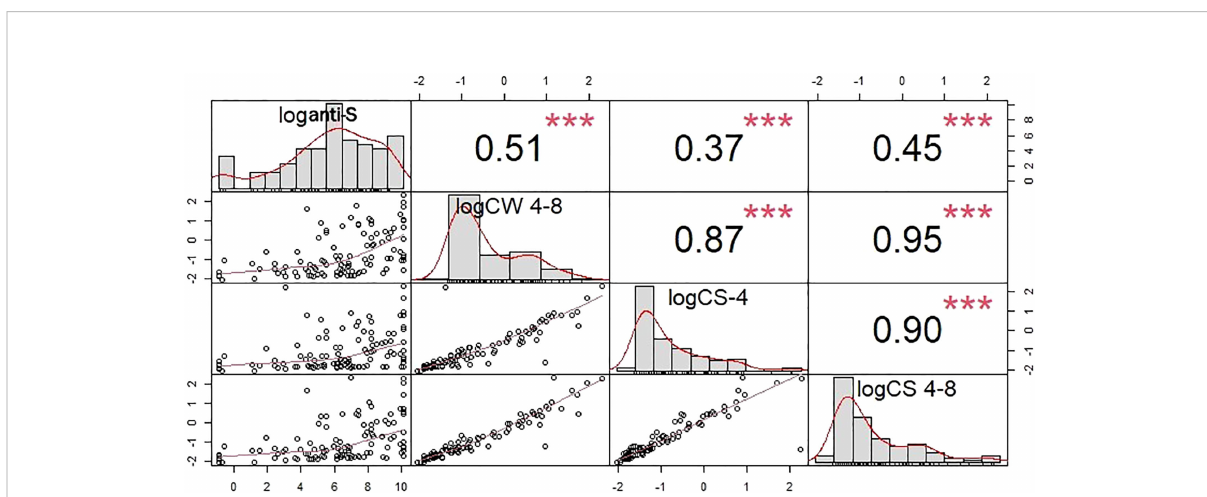
FIGURE 4 Cross-correlation plots between the humoral and T-cell speci fi c response markers. The square of the correlation coef fi cients between of humoral and T cell speci fi c immune responses are shown in the upper right triangle. Correlations were computed after the taking the logarithms of the corresponding concentrations. COVID -speci fi c CD4+ activation was assayed by measuring CS-4, CD4+ and CD8+ activation by CS 4-8, and the whole COVID virus-speci fi c CD4+ and CD8+ T-cell response by CW 4-8. loganti-S – logarithm of anti-S antibody concentration*** p<0.001. T-cell speci fi c response markers are strongly correlated with each other. Because of that the whole COVID virus- speci fi c CD4+ and CD8+ T-cell response was in the statistical